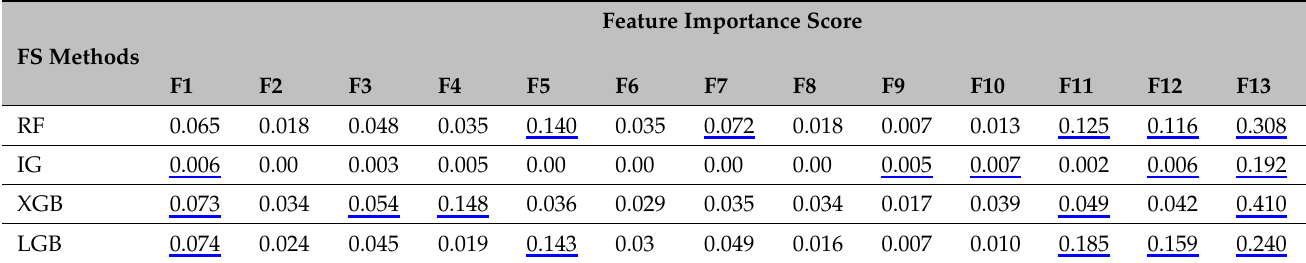
Table 5. Feature importance score in accordance with the four different FS strategies (RF, IG, XGB, and LGB). The five most significant features of individual models are underlined in